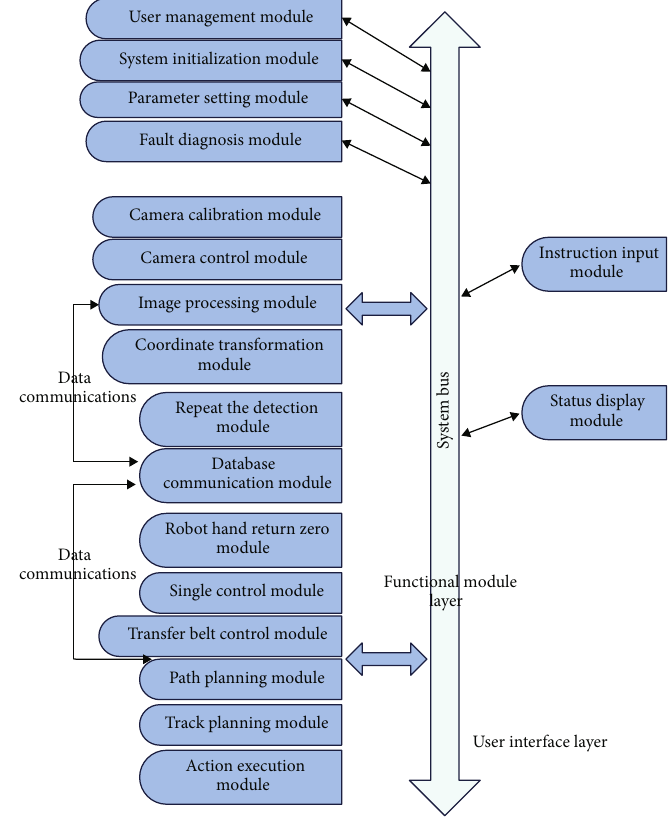
Figure 5: Software module